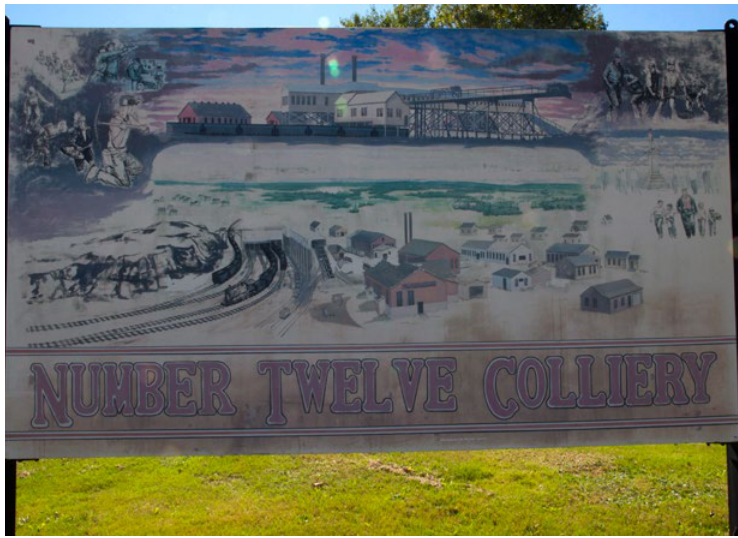
Figure 3. Number 12